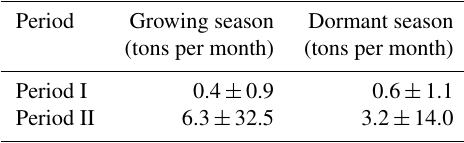
Table 4. Monthly mean sediment loads and associated standard de- viations of different